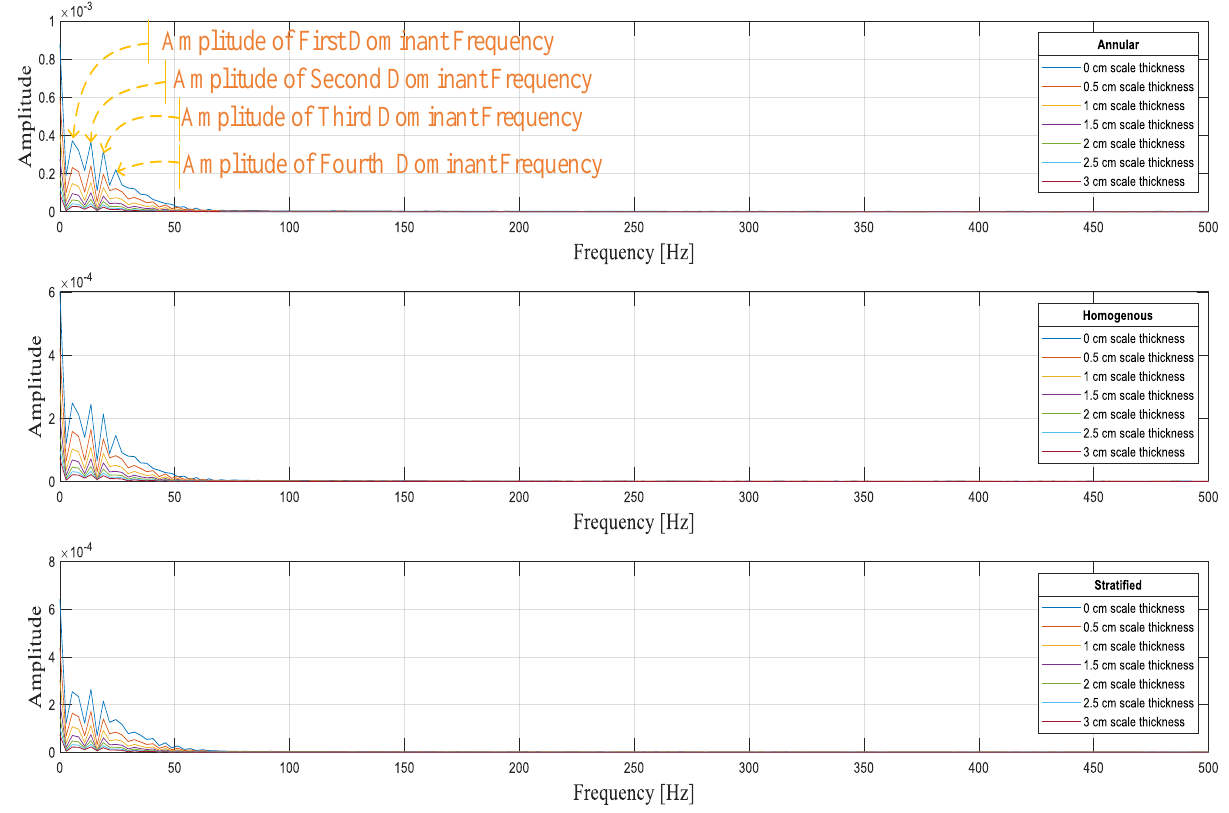
Figure 4. Converted signals of Figure 3 into the frequency domain.